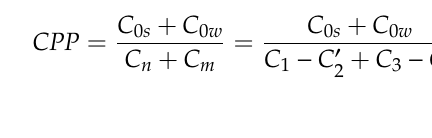
Table 12. Economic reference data for assessing the annual comprehensive benefit of the system.